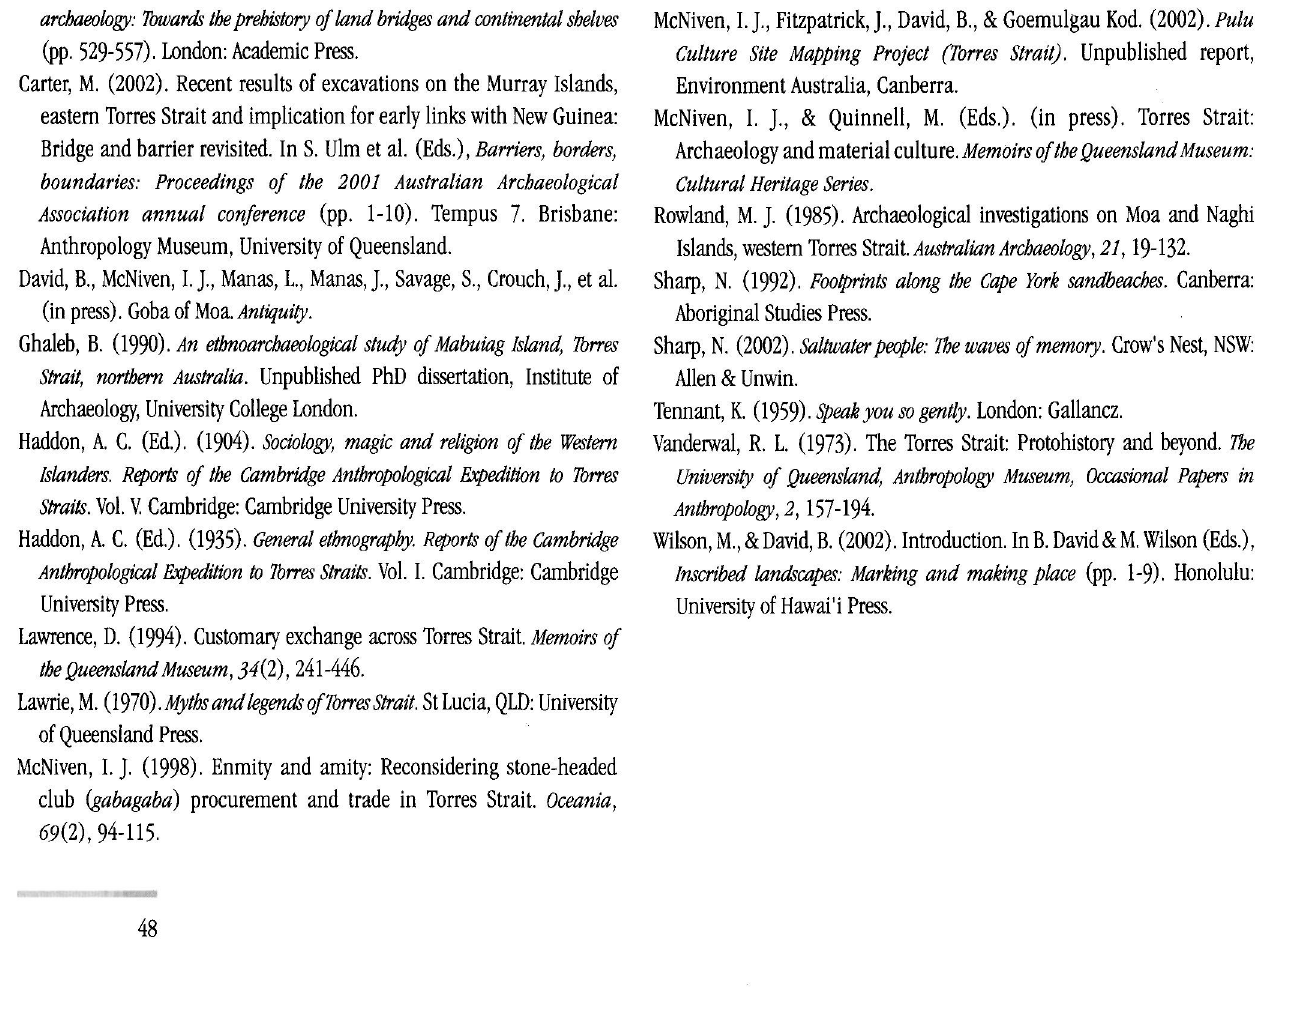
HP F Figure 5. Visit to Turao Kula by Mualgal elders, youths and archaeologists, October 2002.